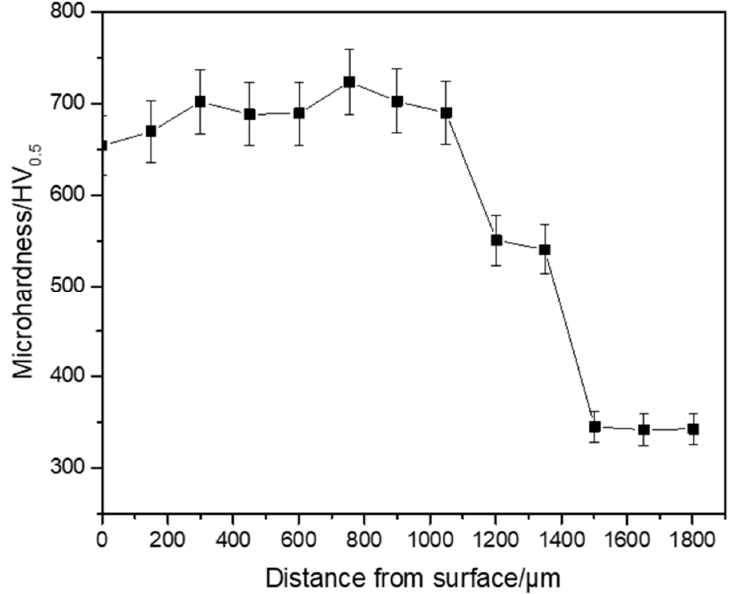
Figure 4. Microhardness distribution of alloying coating.